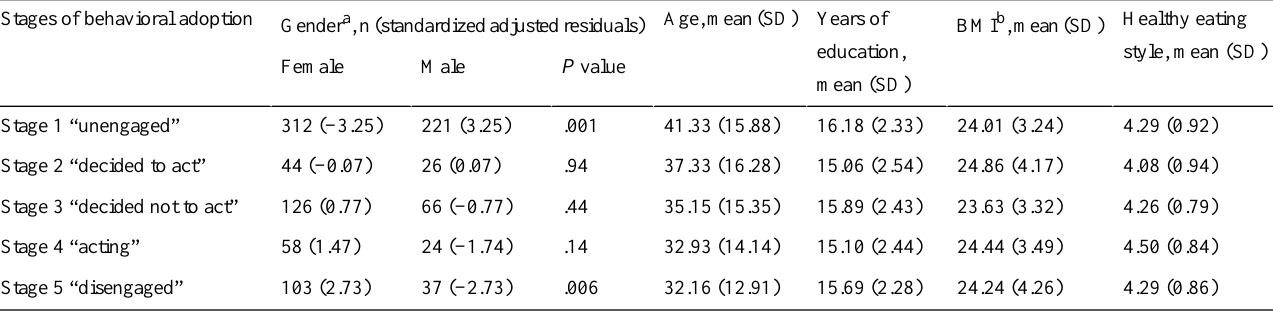
Table 1. Descriptive statistics of correlates of nutrition app